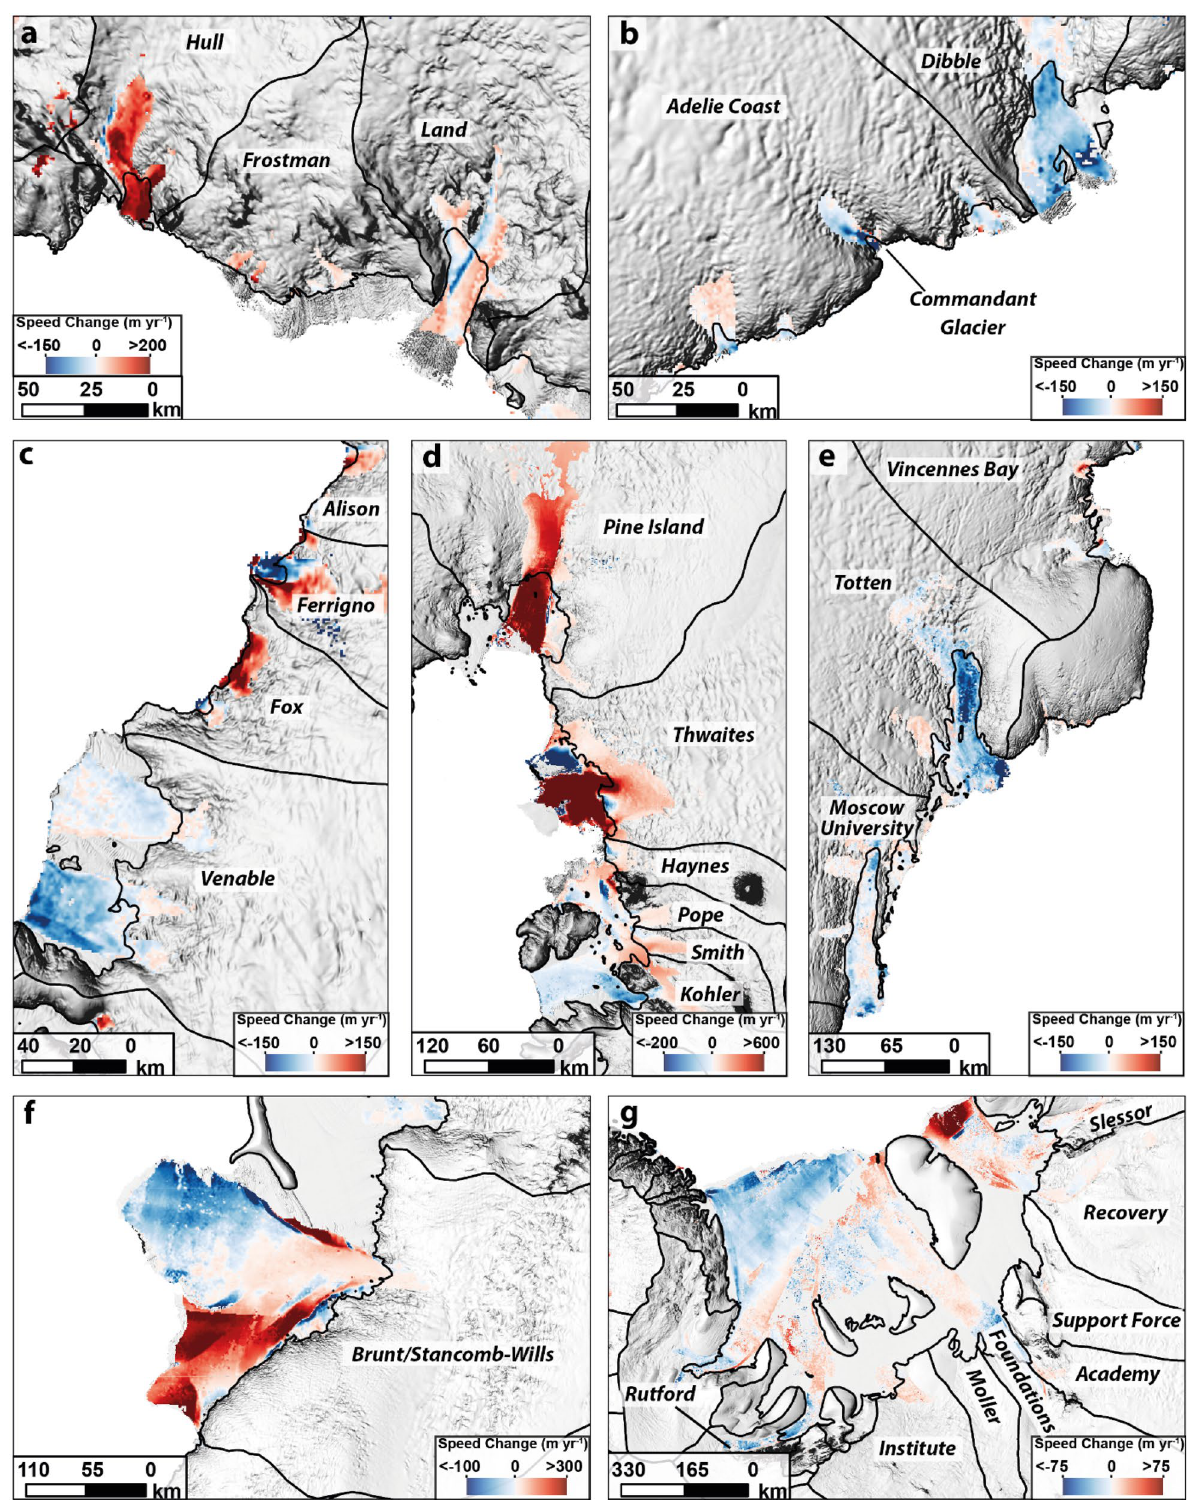
Figure 3. Spatial pattern of ice speed change between 1999–2006 and 2018 where ice flow speed is greater than 200 m year −1 for ( a ) Land and Hull catchments ( b ) Adelie Coast and Dibble catchments ( c ) Venable, Fox and Ferrigno catchments ( d ) the Amundsen Sea sector, ( e ) Totten and Moscow University catchments ( f ) Brunt/ Stancomb-Wills catchment and ( g ) The Filchner-Ronne Ice Shelf. All velocity maps are overlain on the REMA mosaic 61 . Figure was generated using ArcMap GIS software (https:// www. arcgis.